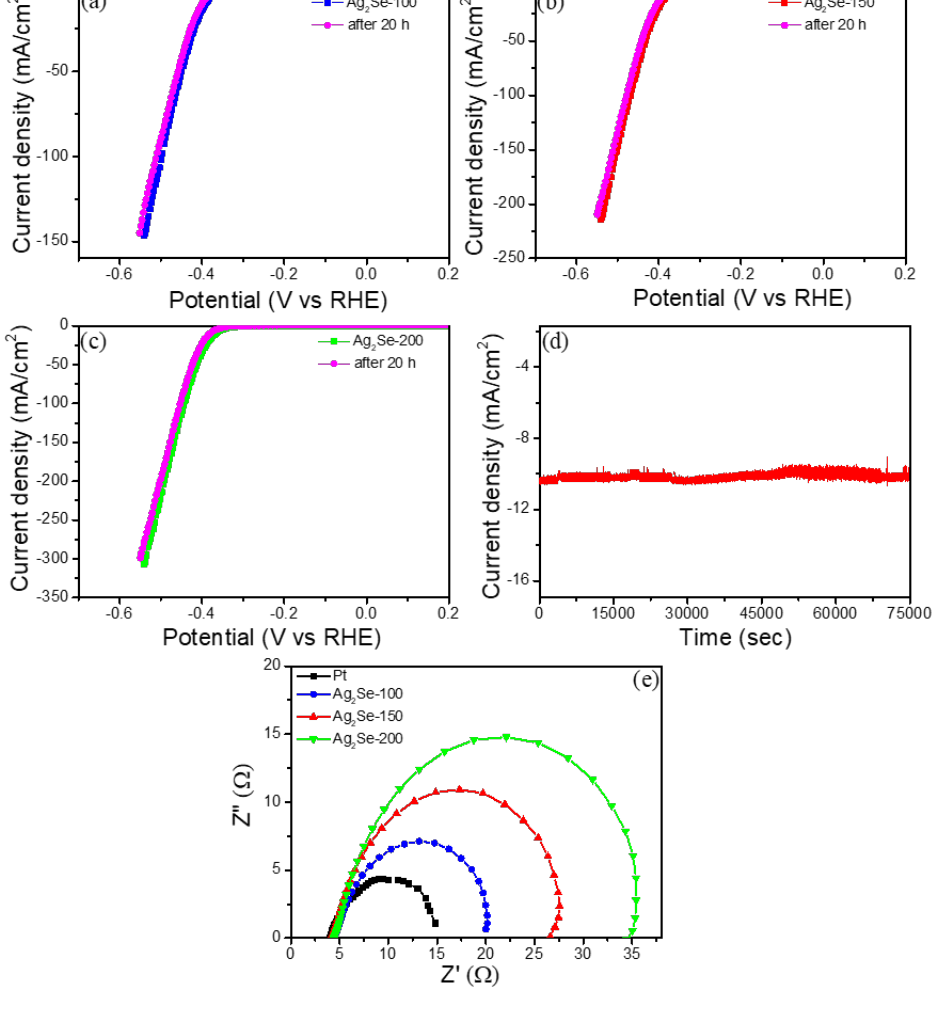
Figure 6. ( a – c ) Polarization curves of Ag 2 Se catalysts before and after 20 h HER performance, ( d ) Chronoamperometric responses ( j-t ) recorded for Ag 2 Se-200 at a constant overpotential, ( e ) electrochemical impedance spectroscopy (EIS) spectra for Pt and Ag 2 Se